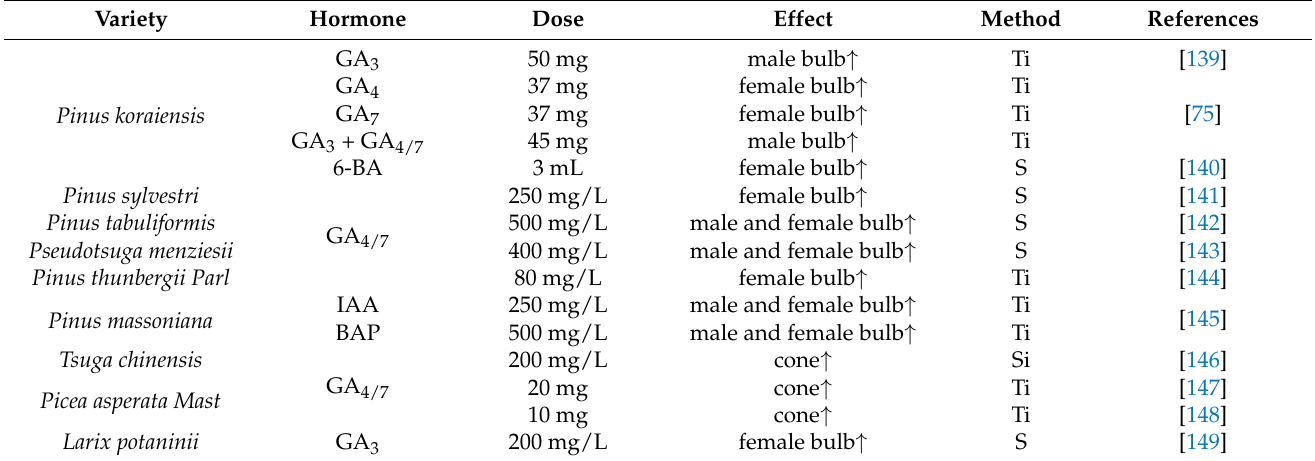
Table 2. Studies on the effect of hormone on flowering and seed production of conifer species.